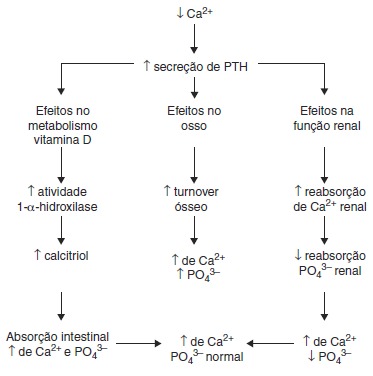
Mecanismos regulatórios dos níveis séricos de cálcio e fósforo. Adaptado
de Ross AC et al.7 PTH, hormônio da paratireoide; Ca2+, íon cálcio; PO43-,
íons fosfato; ↑, aumento; ↓, redução.